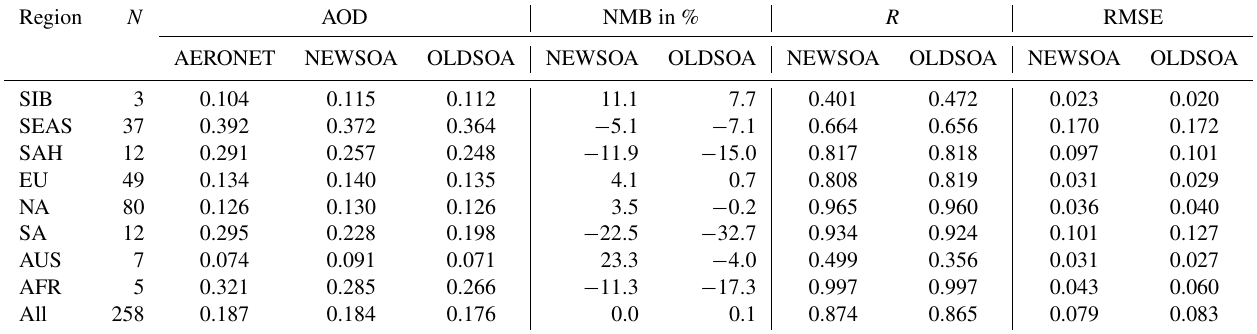
Table 5. Annual mean AERONET AOD at 550nm, the normalised mean bias (NMB), correlation coefficient ( R ) and root mean square error (RMSE) for simulations NEWSOA and OLDSOA. The number of stations is denoted with N . The regions listed in the first column are indicated in Fig.